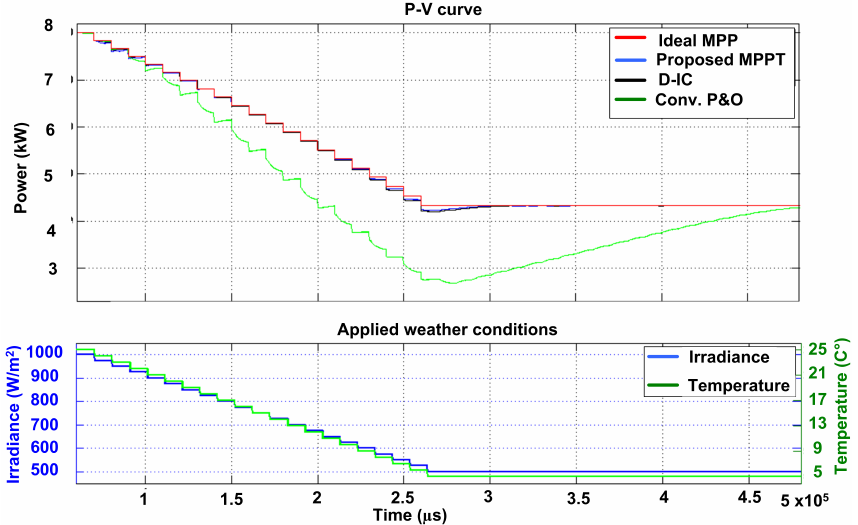
Figure 12. Case 3: Response of three algorithms against step decrement in weather